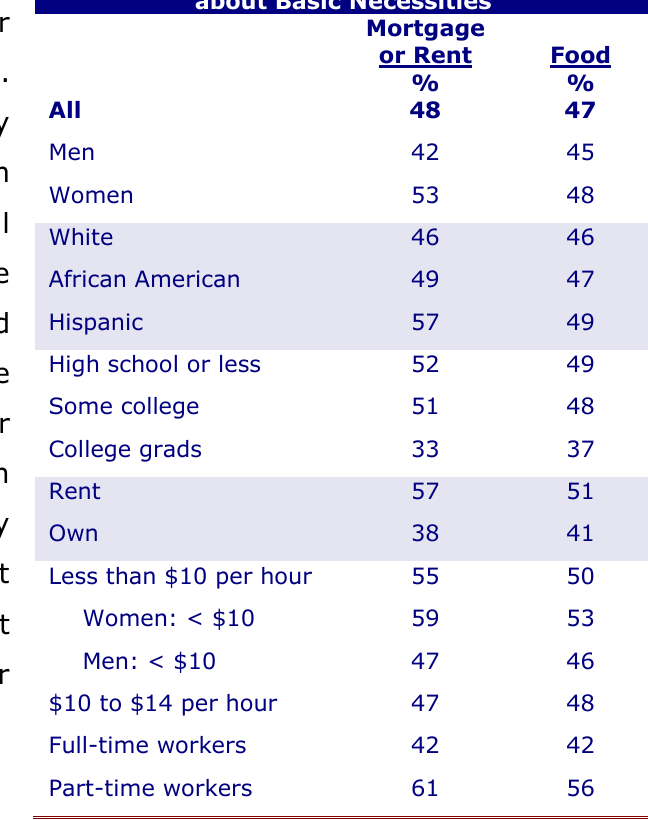
Table 3: Worry Frequently or Sometimes about Basic